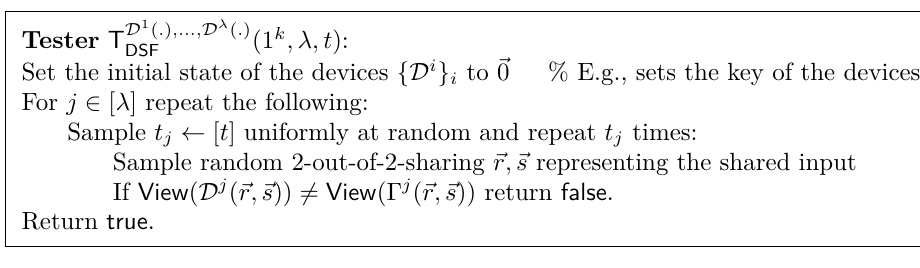
Figure 4: The tester T DSF from [DFS16] slightly adjusted to our notation. View ( D j ( ~r,~s